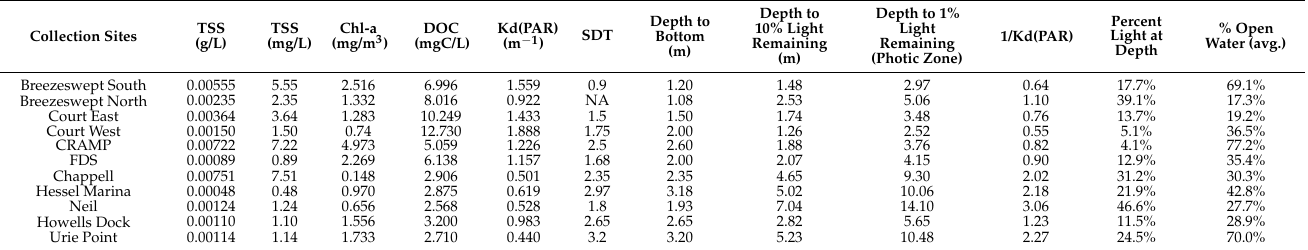
Table 3. Summary of water chemistry and light calculations by